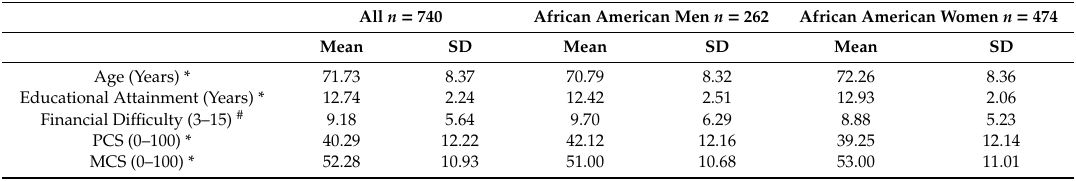
MCS: Mental Component Score; PCS: Physical Component Score; SD: Standard Deviation. # p < 0.1, * p < 0.05 (Independent sample t